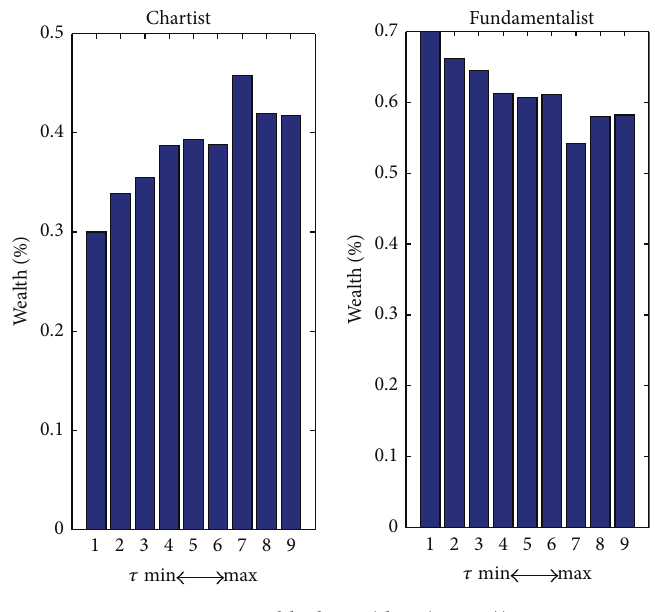
Figure 8: Wealth Shares (𝑑 𝑓 ∈ (0.6,0.7)) .